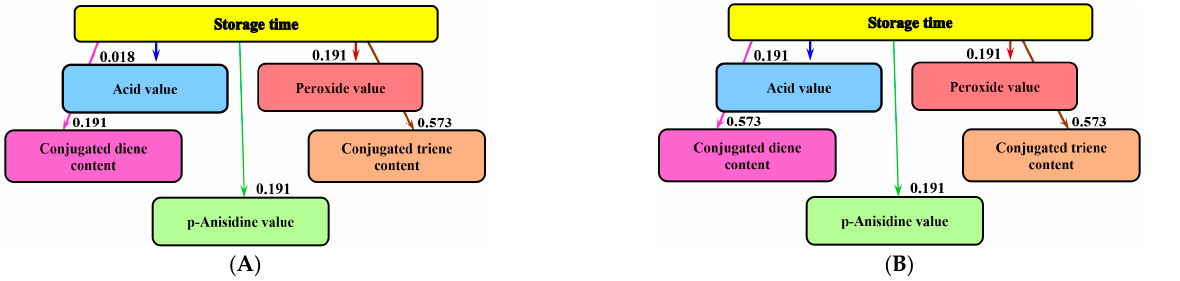
Figure 4. Informational analysis regarding the in fl uence of storage time on the physicochemical quality indices of the lipophilic extracts: ( A ) sea buckthorn; ( B ) rose hip.